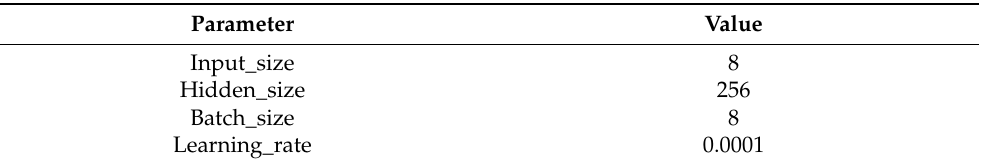
Table 2. Setting of GRU